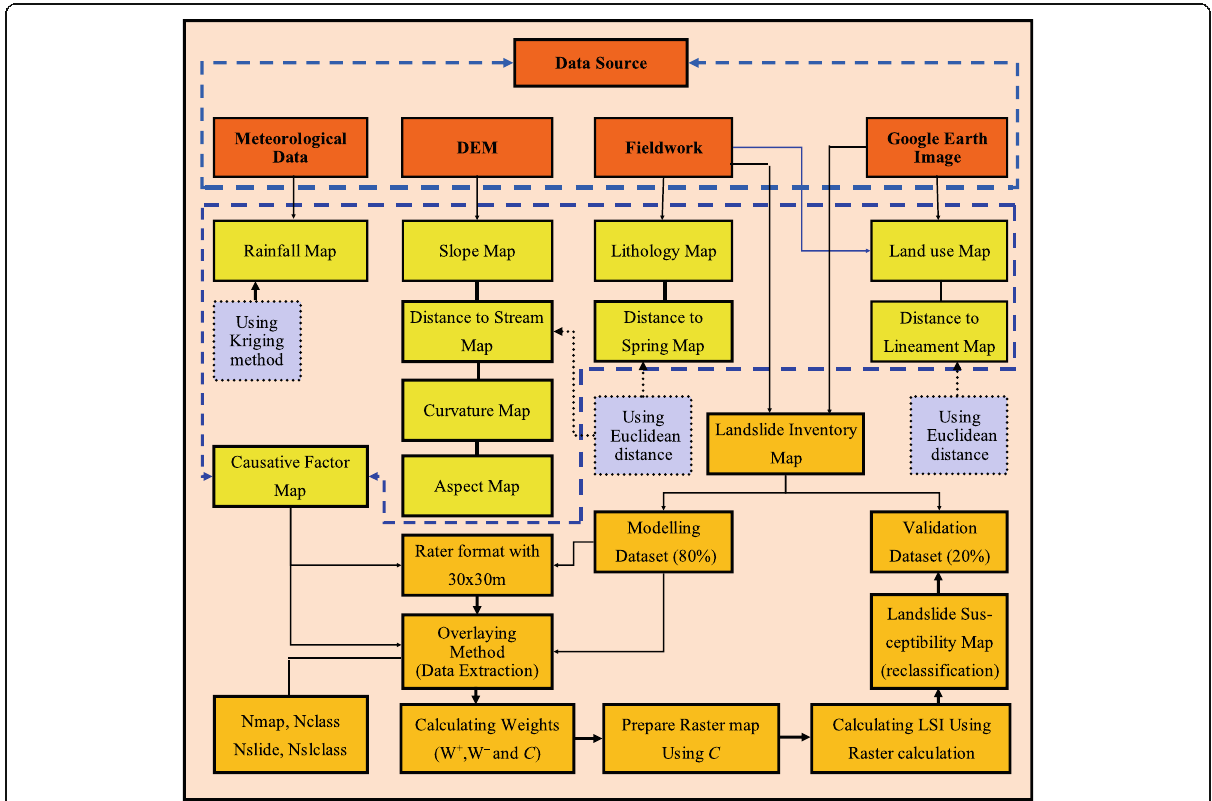
Fig. 4 The general methodological framework of the